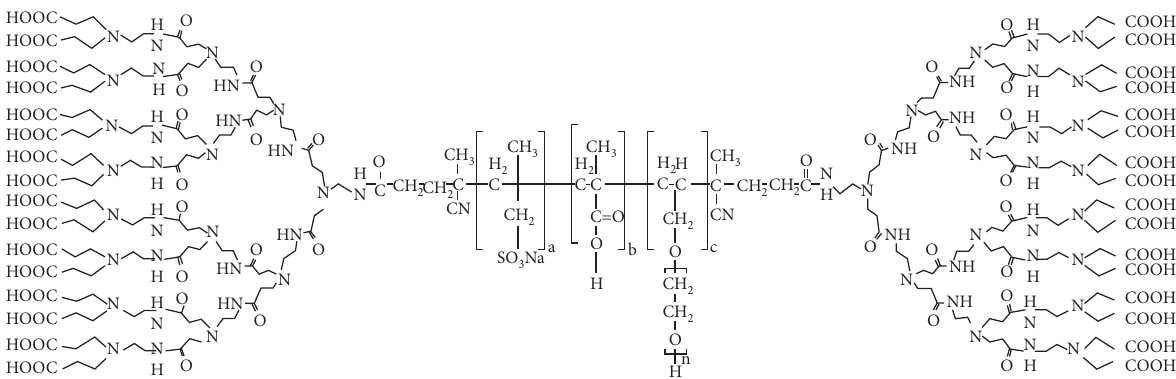
Figure 6: Molecular structure of hyperbranched PCE (amide